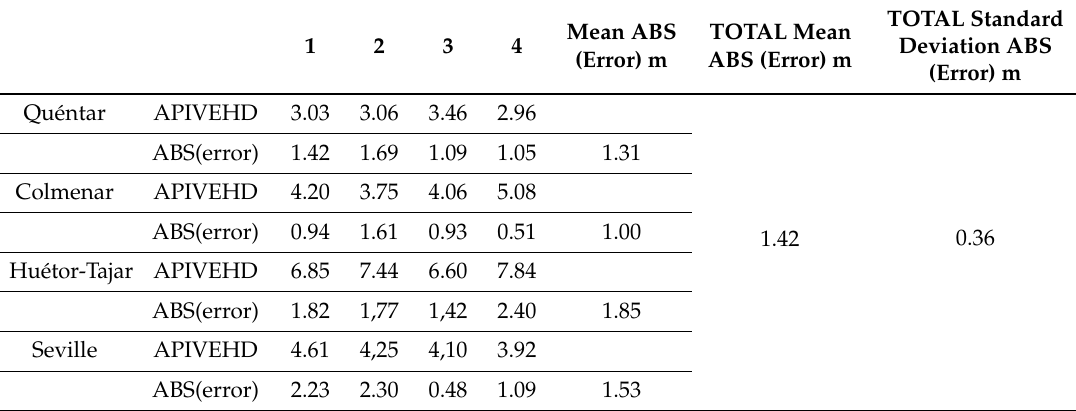
Table 9. PIVED after applying the scale factor (APIVED). Small interrogation